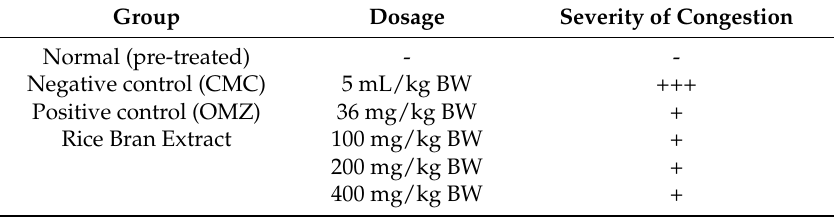
Degrees of severity: mild (+) and heavy